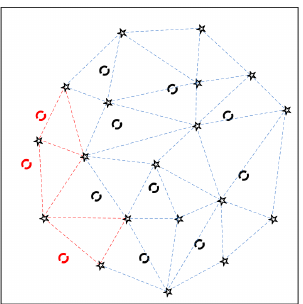
Figure 8. Schematic diagram of matching points outside Delaunay triangulation.